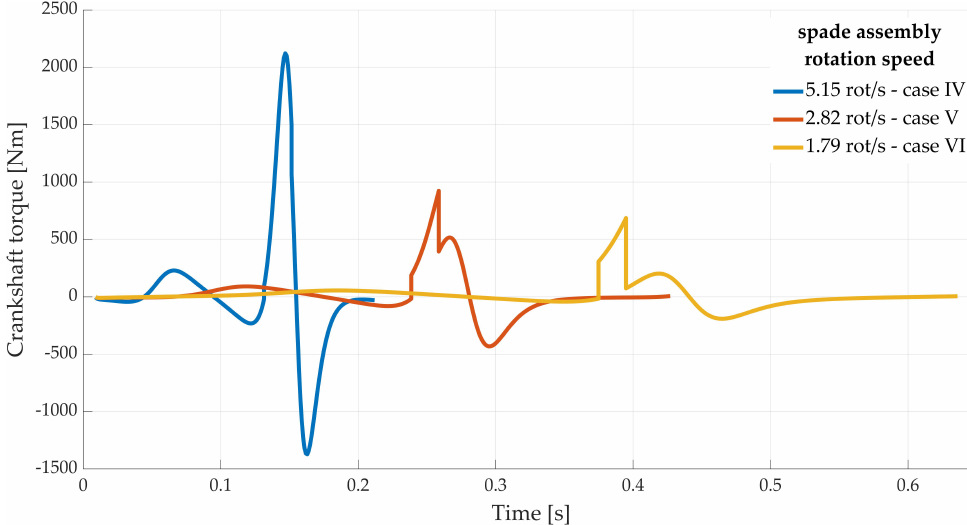
Figure 12. Effect of shear load on the crankshaft torques using working depth of 0.28 m and machine advancing speed of 0.35 m/s (first cycle presented).